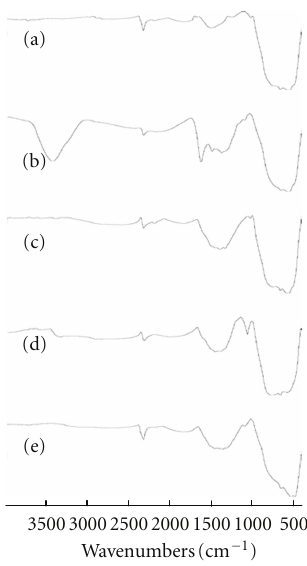
Figure 2: FTIR spectra of powder